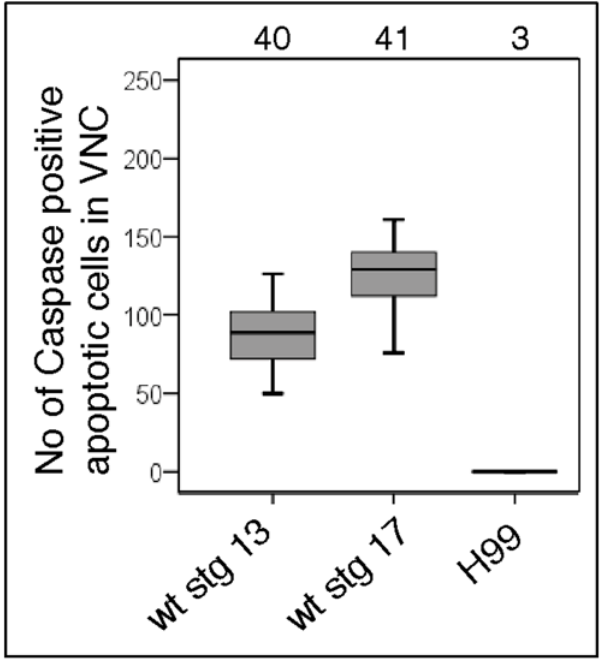
Figure 6. Examples of application of DeadEasy Caspase to address biological questions. DeadEasy Caspase is used to count the number of apoptotic cells stained with Caspase in wild-type embryos at different stages and in H99 mutants lacking apoptosis. Numbers over box-plots indicate number of embryos analysed per